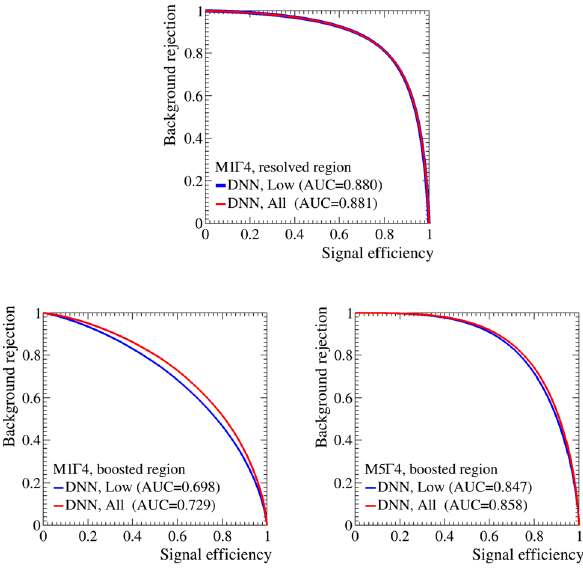
Fig. 5 ROC curves, comparing the performance with (“all”) and with- out (“low”) high-level observables used to train DNNs. The AUC of each curve is also shown inside